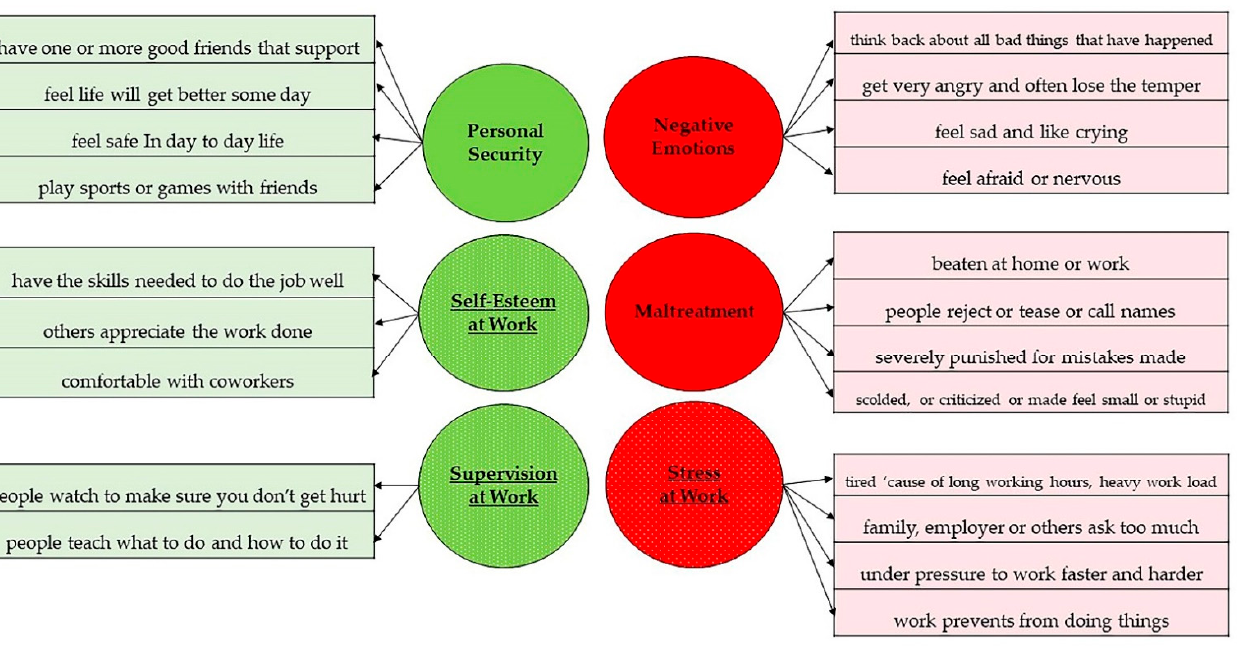
Figure 1. IPAW’s factorial structure (adapted with permission from Pellenq et al., 2021 [18]).